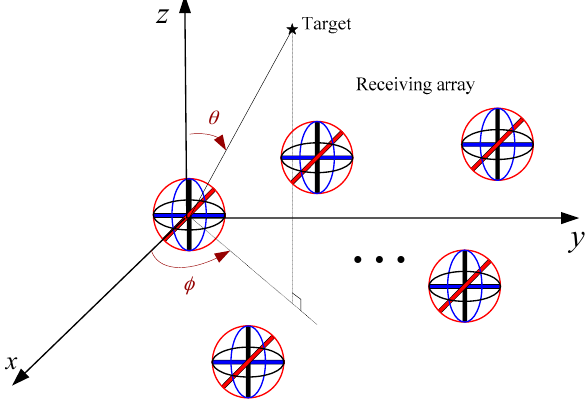
Figure 1. Monostatic MIMO radar with arbitrarily spaced centralized EMVSs.